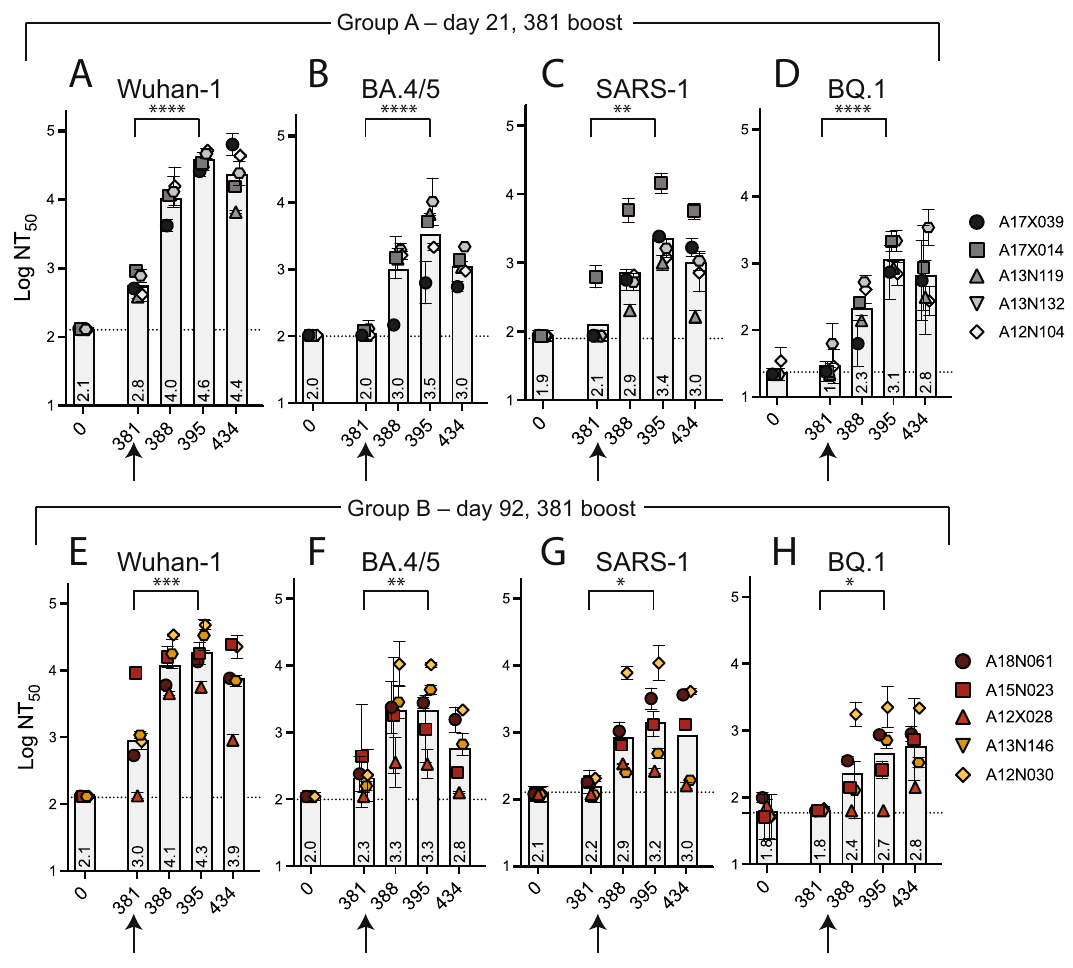
Fig. 5 | Robust serum neutralizing anamnestic responses following a second booster of DCFHP-alum after ~one year in NHPs. A Pseudovirus neutralization against Wuhan-1 ( A ), BA.4/5 ( B ), SARS-1 ( C ), or BQ.1 ( D ) by antisera from NHPs in groupAfollowingaboostatday381.Daysshownonxaxis. E – H Asinpanels( A – D ) but with NHPs in group B. NHP identi fi cation provided correlate with SI Table 1 ( n =2, n = number of replicate neutralization assays conducted for these samples